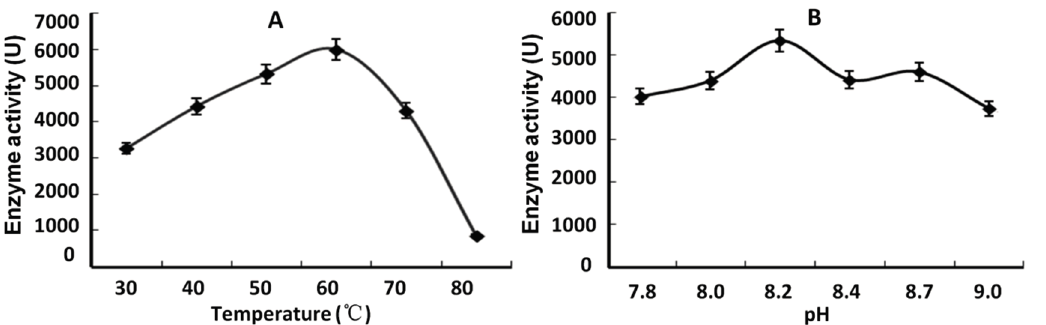
Figure 9. Characterization of recombinant SsPAL1 expressed in E. coli BL21 (DE3). ( A ) Optimal temperature analysis of recombinant SsPAL1 ; ( B ) optimal pH analysis of recombinant SsPAL1 . Data represent the mean values of three replicates